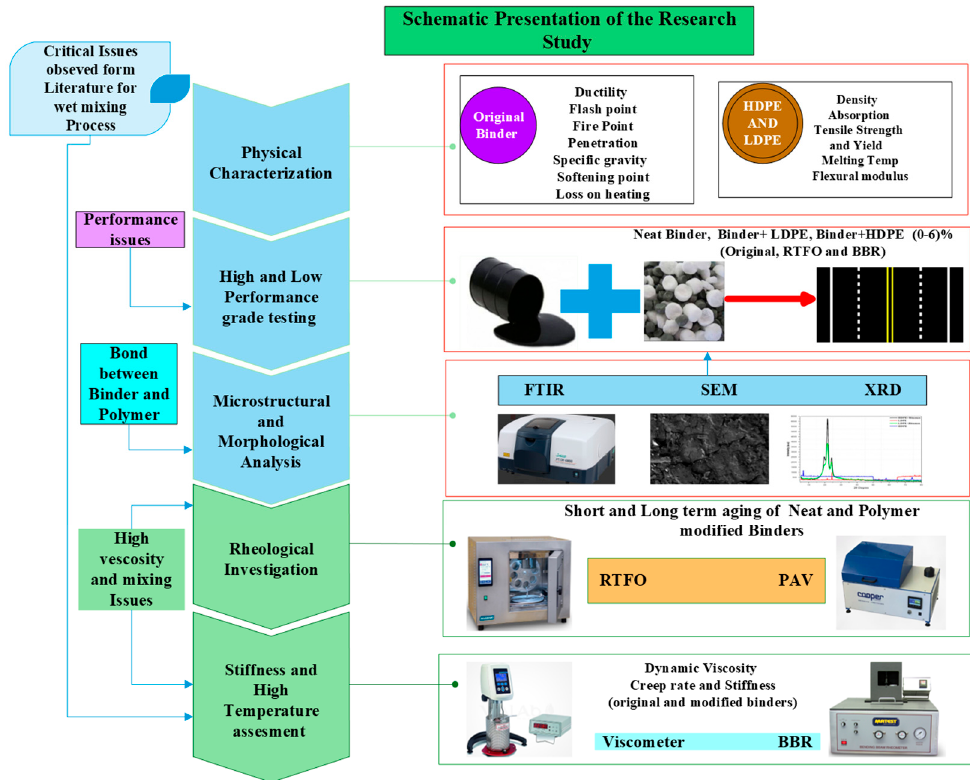
Figure 1. A schematic presentation of the critical issues observed in the current literature.